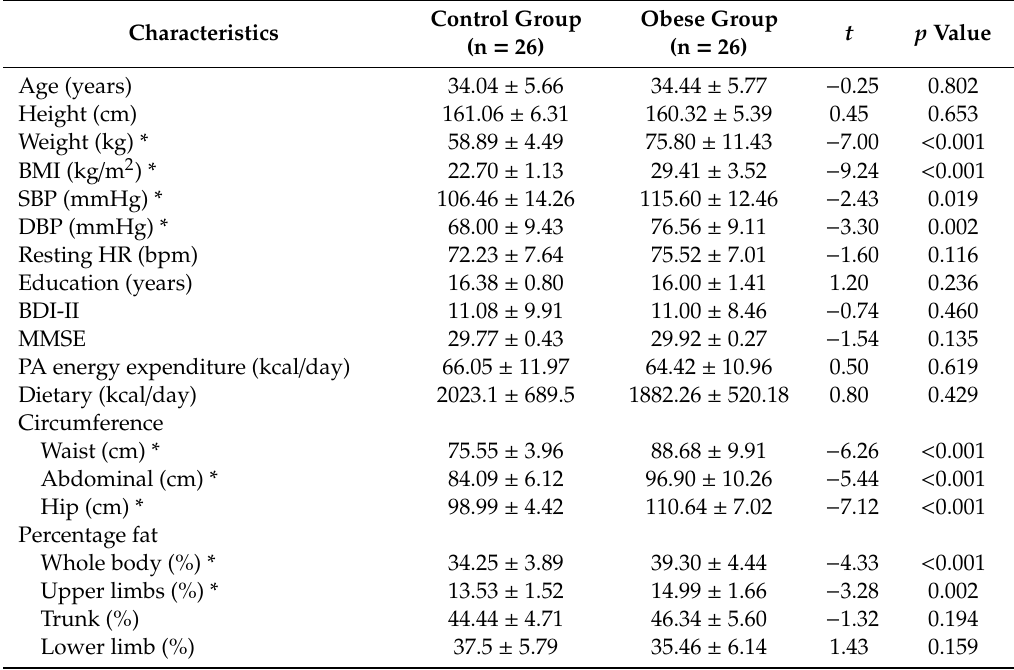
Table 1. Demographic characteristics of the normal-weight (control) and obese women. Characteristics